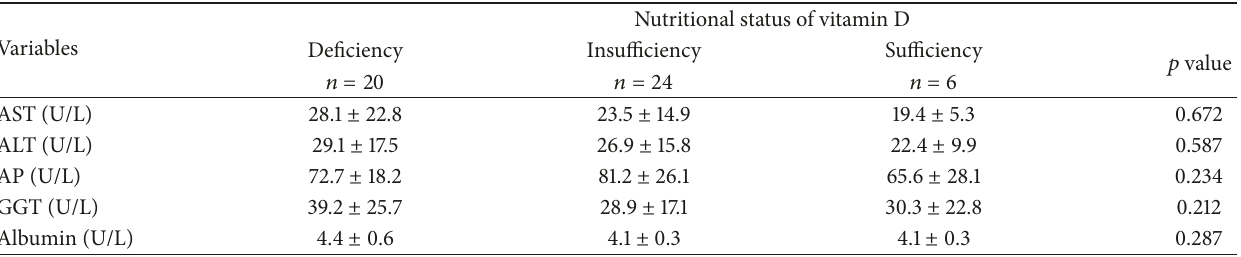
Table 3: Mean serum concentrations of biochemical indicators of liver tests in relation to the nutritional status of vitamin D. Variables